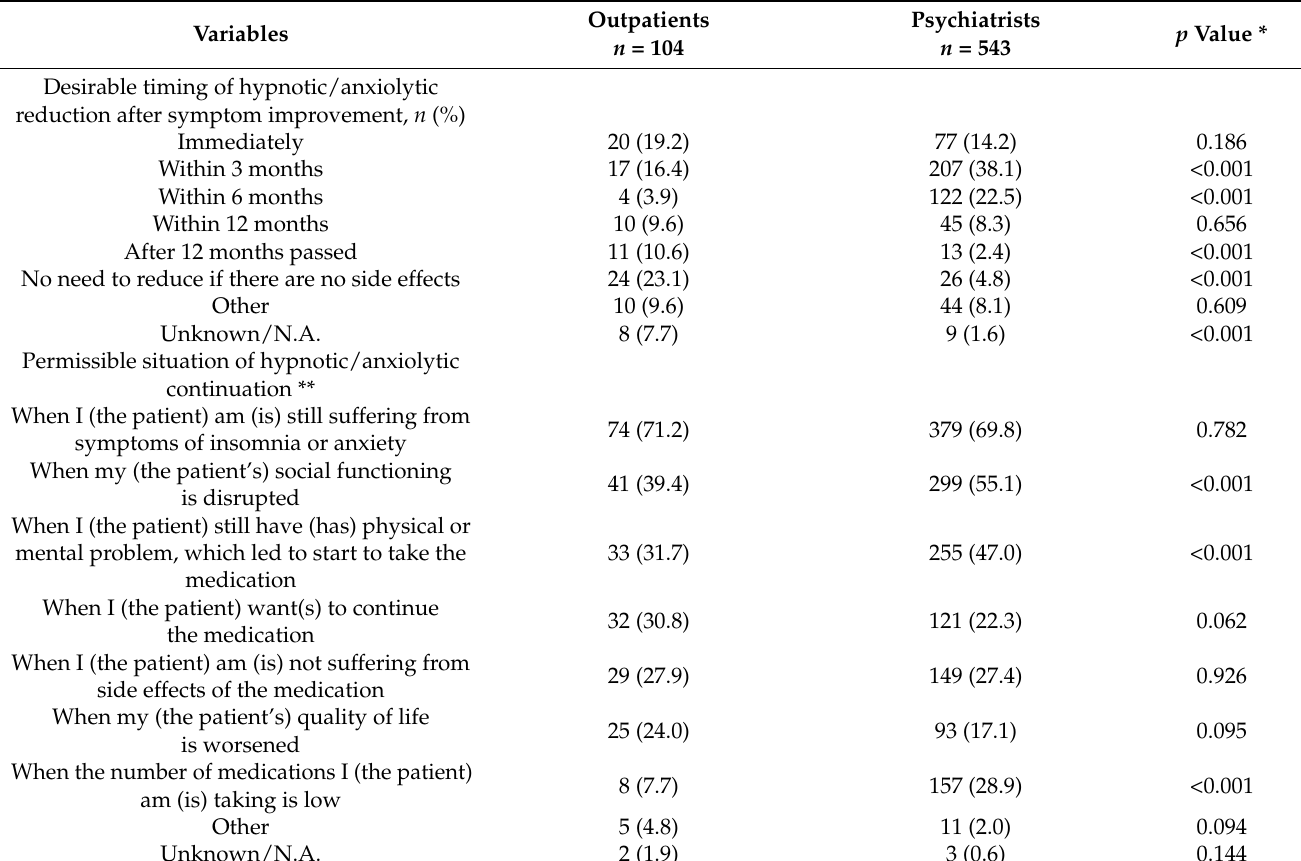
Table 3. Perspectives related to hypnotic/anxiolytic